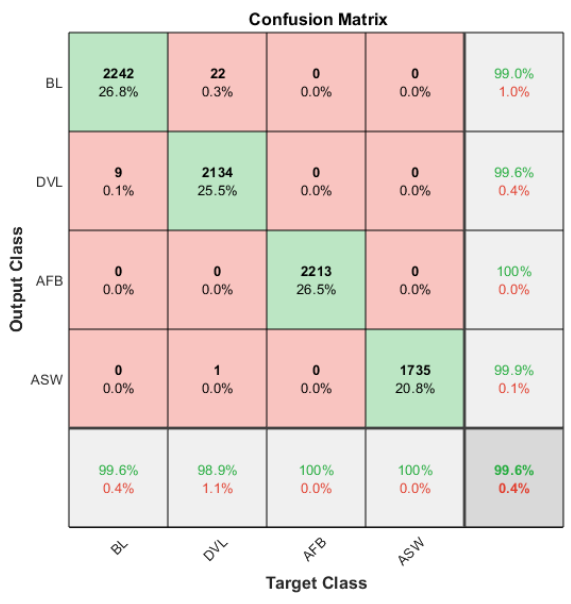
Figure 8. Confusion matrix of the training accuracy.